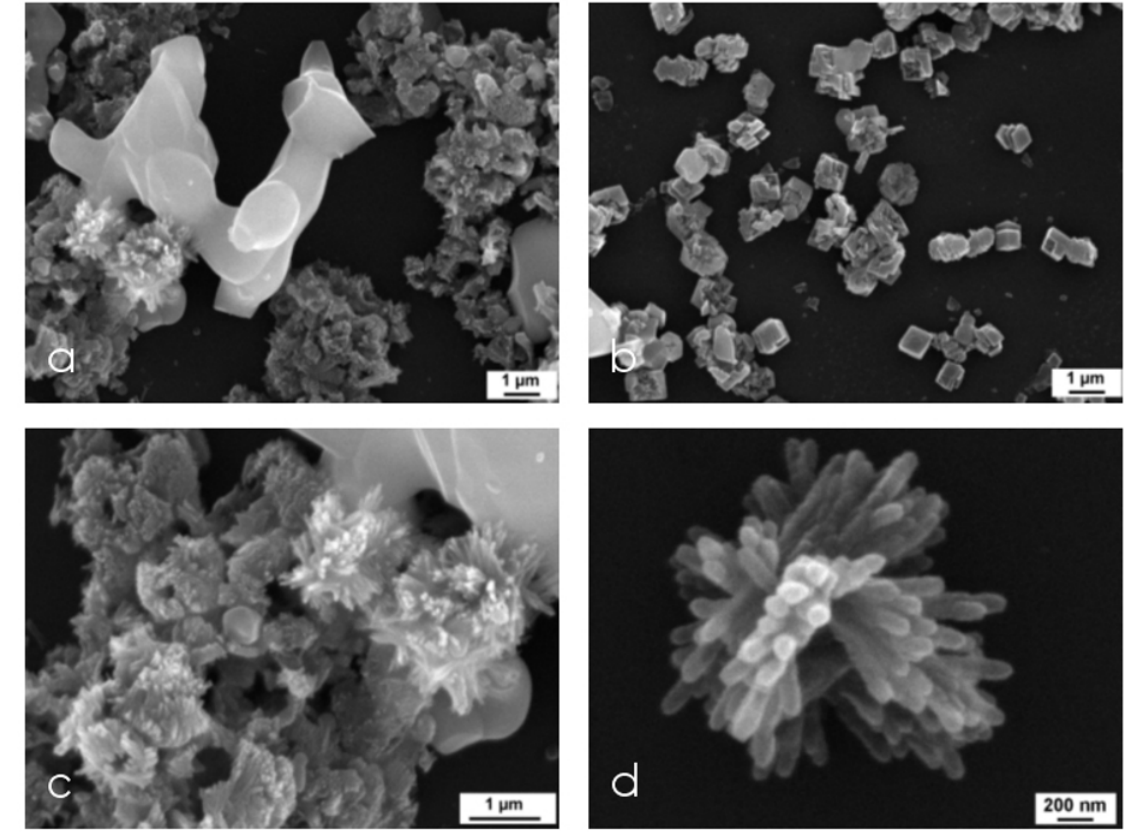
Figure 6. SEM micrographs of HA samples synthesized at 1000 o C from the sol prepared at pH ~5.7. Magnification (a) and (b) 1000X, (c) 2000X, (d)